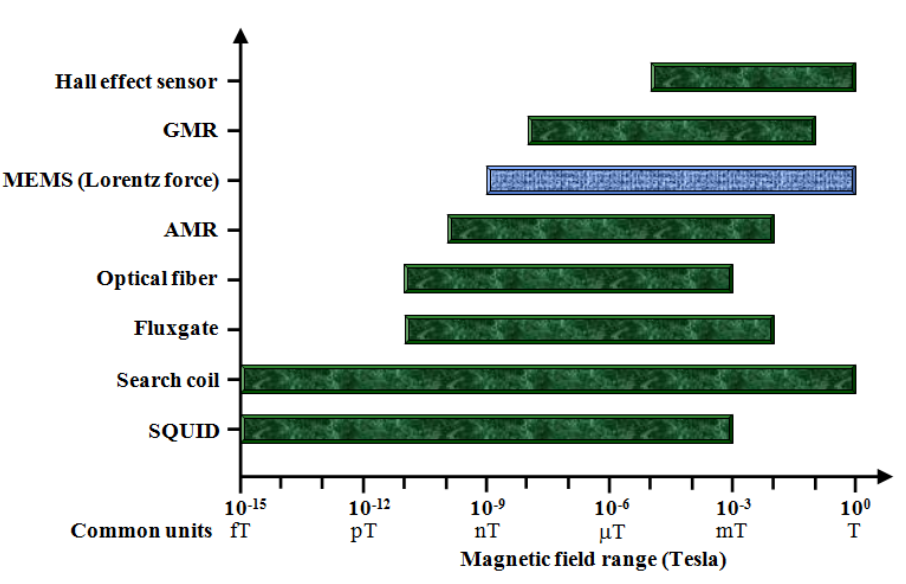
Figure 15. Approximate sensitivity range of different magnetic field sensors